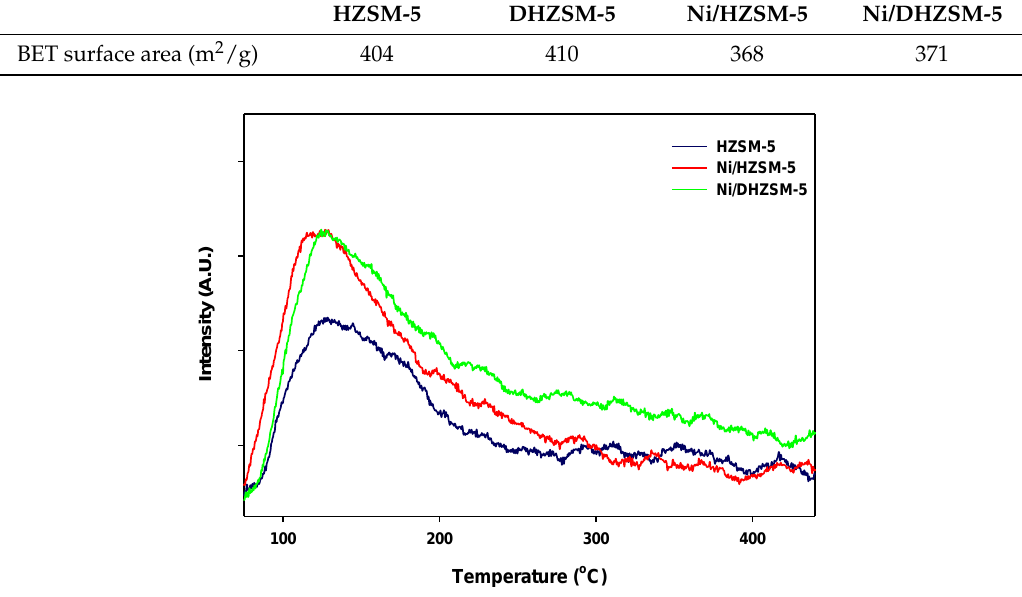
Figure 1. NH 3 -TPD curves of catalysts.